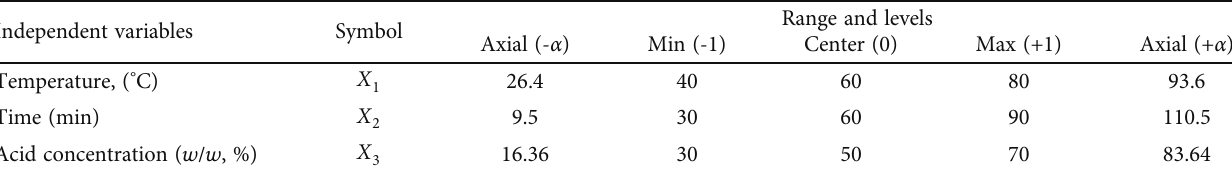
Table 1: CCRD matrix for actual and coded level of hydrolysis factors.